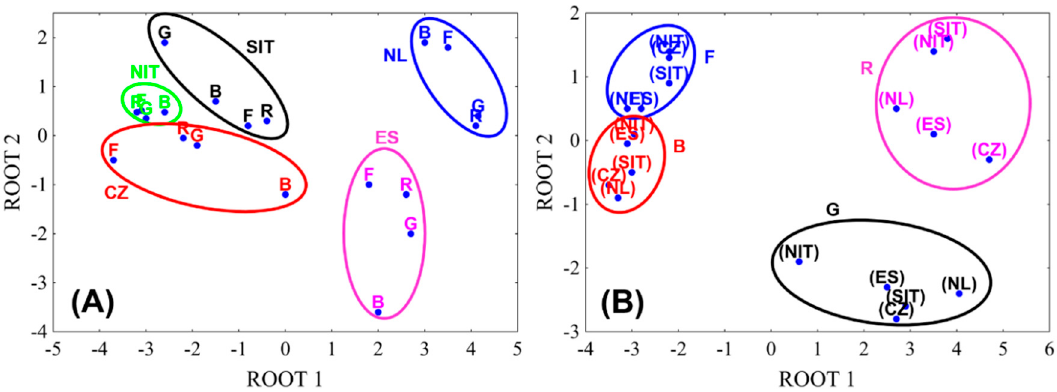
Figure 4. Scatterplots of the linear discriminant scores providing a visual impression of how well the Fisher linear discriminant functions classify the data: ( A ) according to the country of origin (STATISTICA, StatSoft); ( B ) according to the cooking procedure (STATISTICA, StatSoft). F—fresh, B—baked, R—roasted, G—grilled, CZ—Czech Republic, NL—The Netherlands, NIT—Northern Italy, ES—Spain, SIT—Southern Italy.